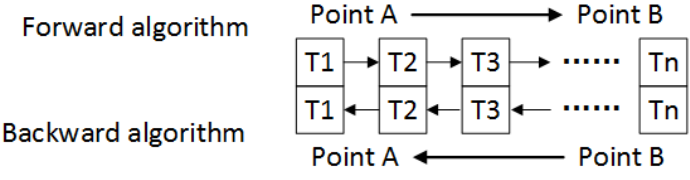
Figure 1. Time sequence in forward and backward